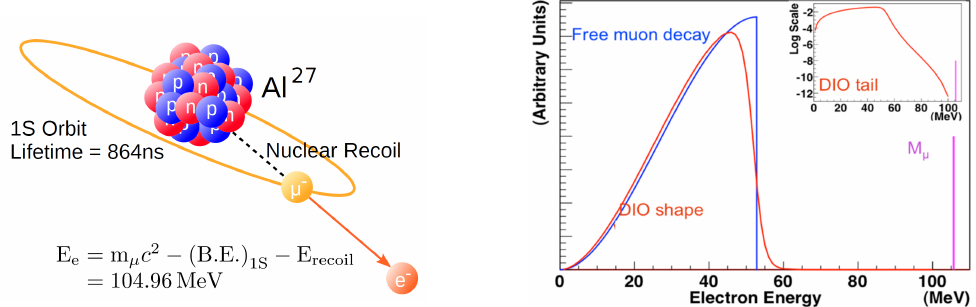
e conversion of a muon bound in the 1s state of an aluminum Figure 2: Illustration of the neutrino-less µ Figure 5: (Left) Momentum spectra for electrons from the decay of free muons (blue) and from muons ! Figure 1. (Left) Sketch of the muon to electron conversion process. (Right) Energy spectrum for electrons produced from muon decays nucleus. decaying in orbit [DIO] (red). Note the tail for DIO electrons on the high end side of the spectrum close to in orbit. The spectrum is a modified Michel spectrum with a long tail that falls quickly as ( E e − E endpoint ) 5 in proximity to the kinematic the endpoint energy (inset). (Right) Reconstructed momentum spectra for electrons from DIOs (blue) and endpoint. Perfect resolution assumed. conversion electrons (red) obtained from Mu2e simulations performed for the design luminosity of 3 . 6 10 20 ⇥ protons on target and 6 . 7 10 17 stopped muons, and assuming R µ e = 10  16 . ⇥